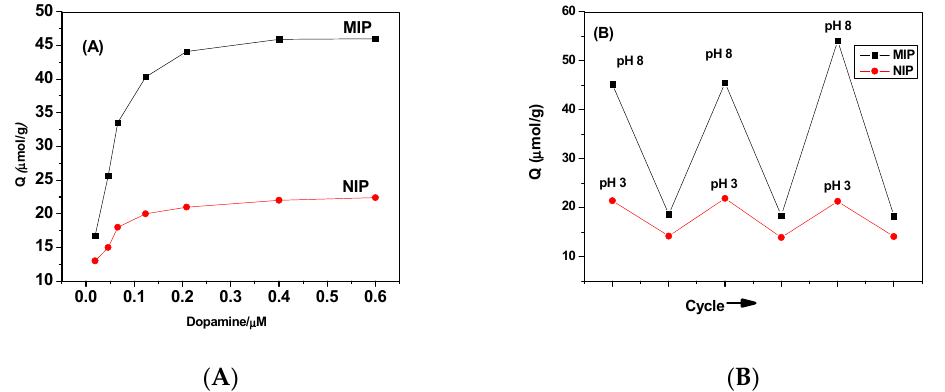
Figure 2. ( A ) Binding isotherms for the prepared polymers; ( B ) binding capacities of both MIP and NIP beads under alkaline (10-mM PBS buffer of pH 7.8) and acid conditions (0.01-M HCl).